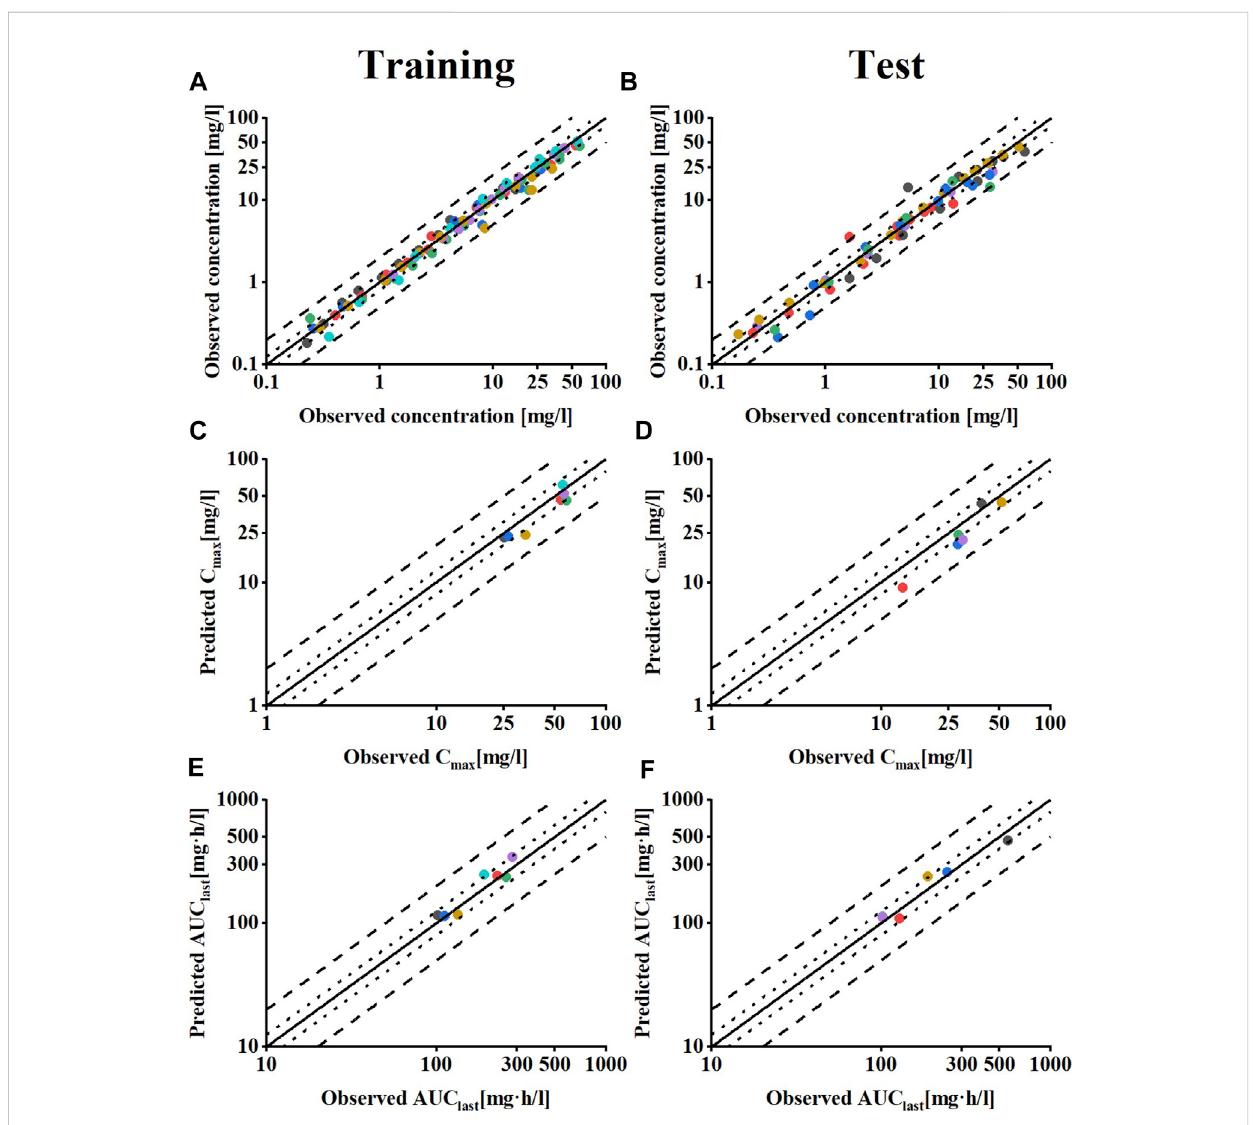
FIGURE 2 Model performance evaluation of meropenem in healthy individuals. Predicted compared to observed meropenem (A,B) plasma concentrations (C,D) C max and (E,F) AUC last values of all clinical studies used, separated by training and test dataset. The solid line marks the line of identity. Dotted lines indicate 1.25-fold, dashed lines indicate 2-fold deviation. Details on the MRD and GMFE values are listed in Supplementary Tables S3 –